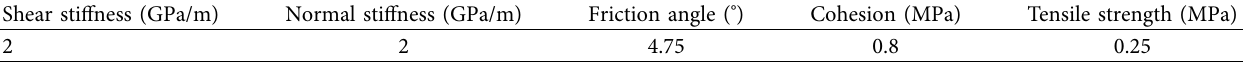
Table 5: Structure plane properties used in the numerical model.